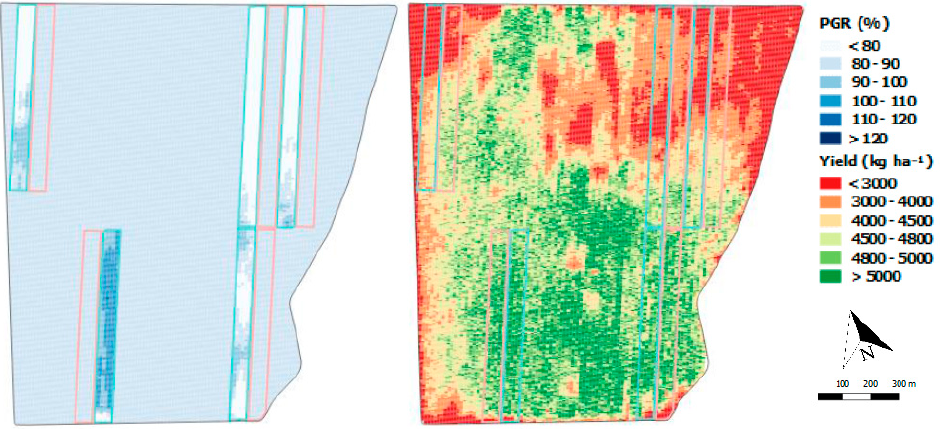
Figure 10. Spatial distribution of applied plant growth regulators and cottonseed yield in narrow row cotton in field NF2.